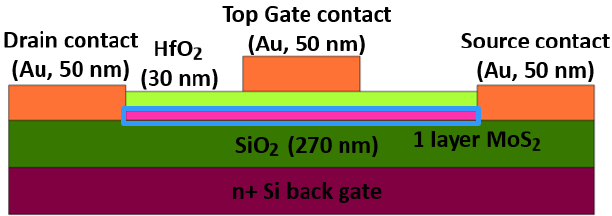
Figure 3. COMSOL HfO 2 model.